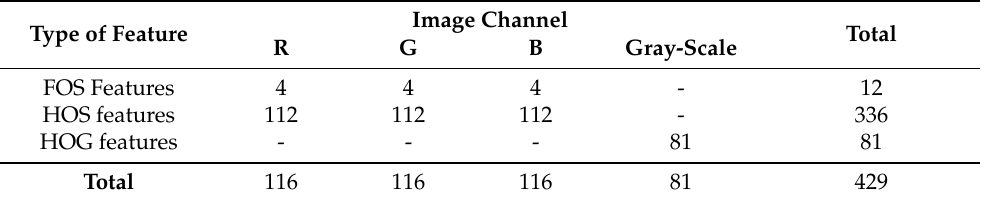
Table 4. Details of the original 429 features, before reduction by